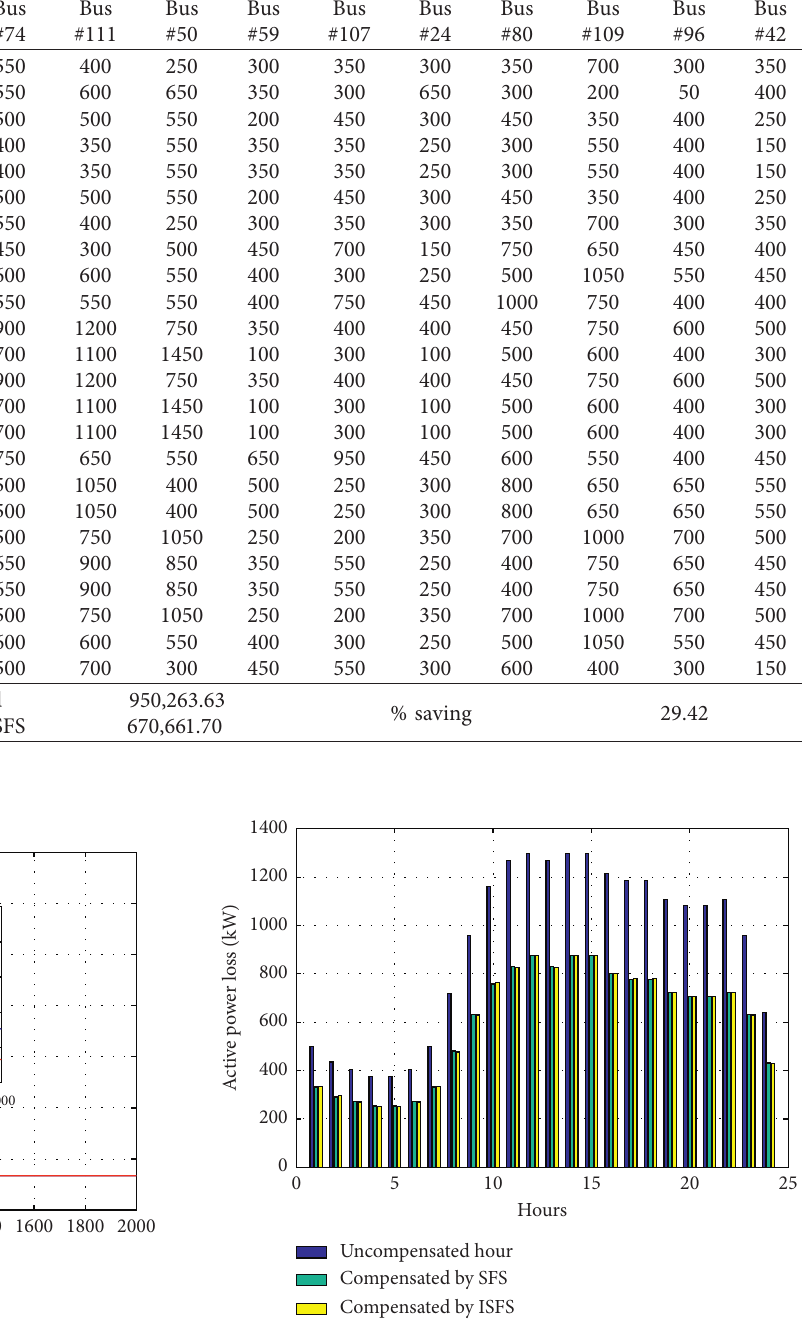
Figure 22: Power losses of 119-bus network within 24-hour in- terval before and after compensation in scenario 2.